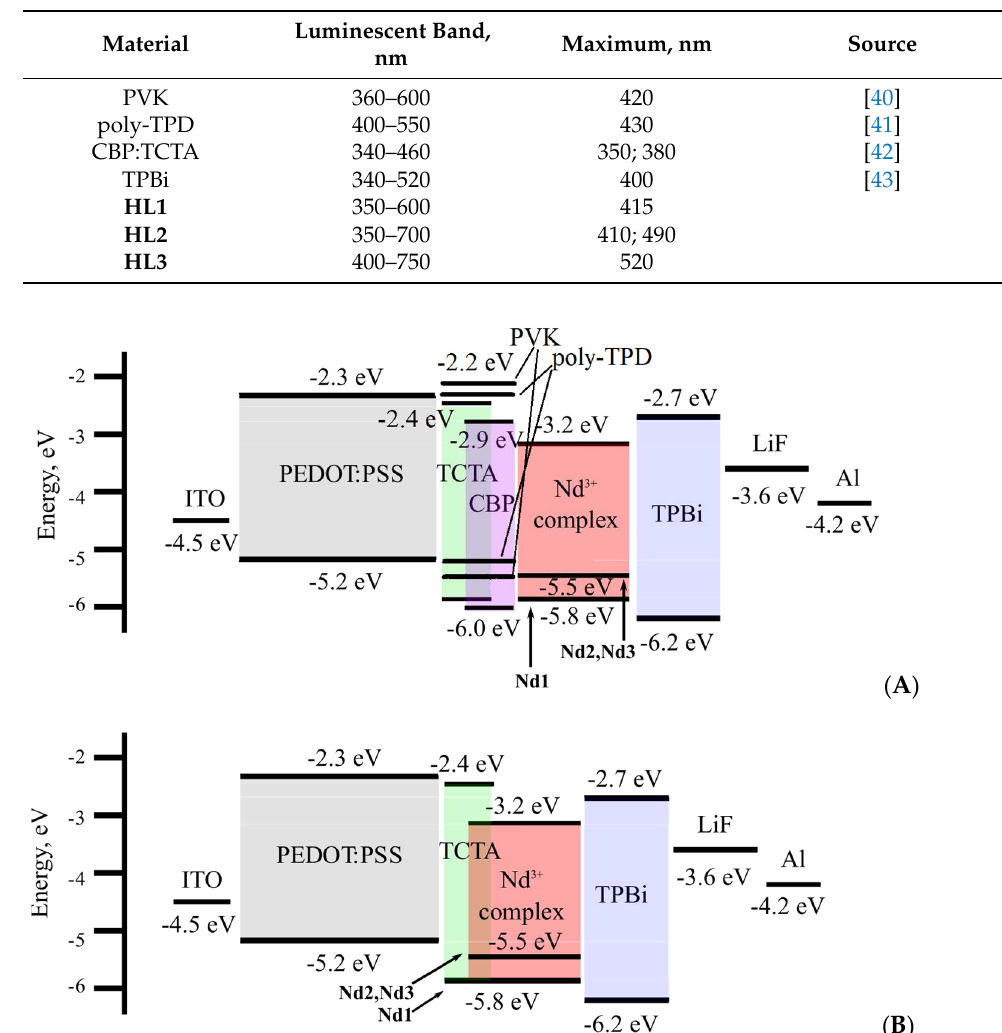
Table 3. Luminescent properties in visible spectral range for the materials employed in OLEDs.